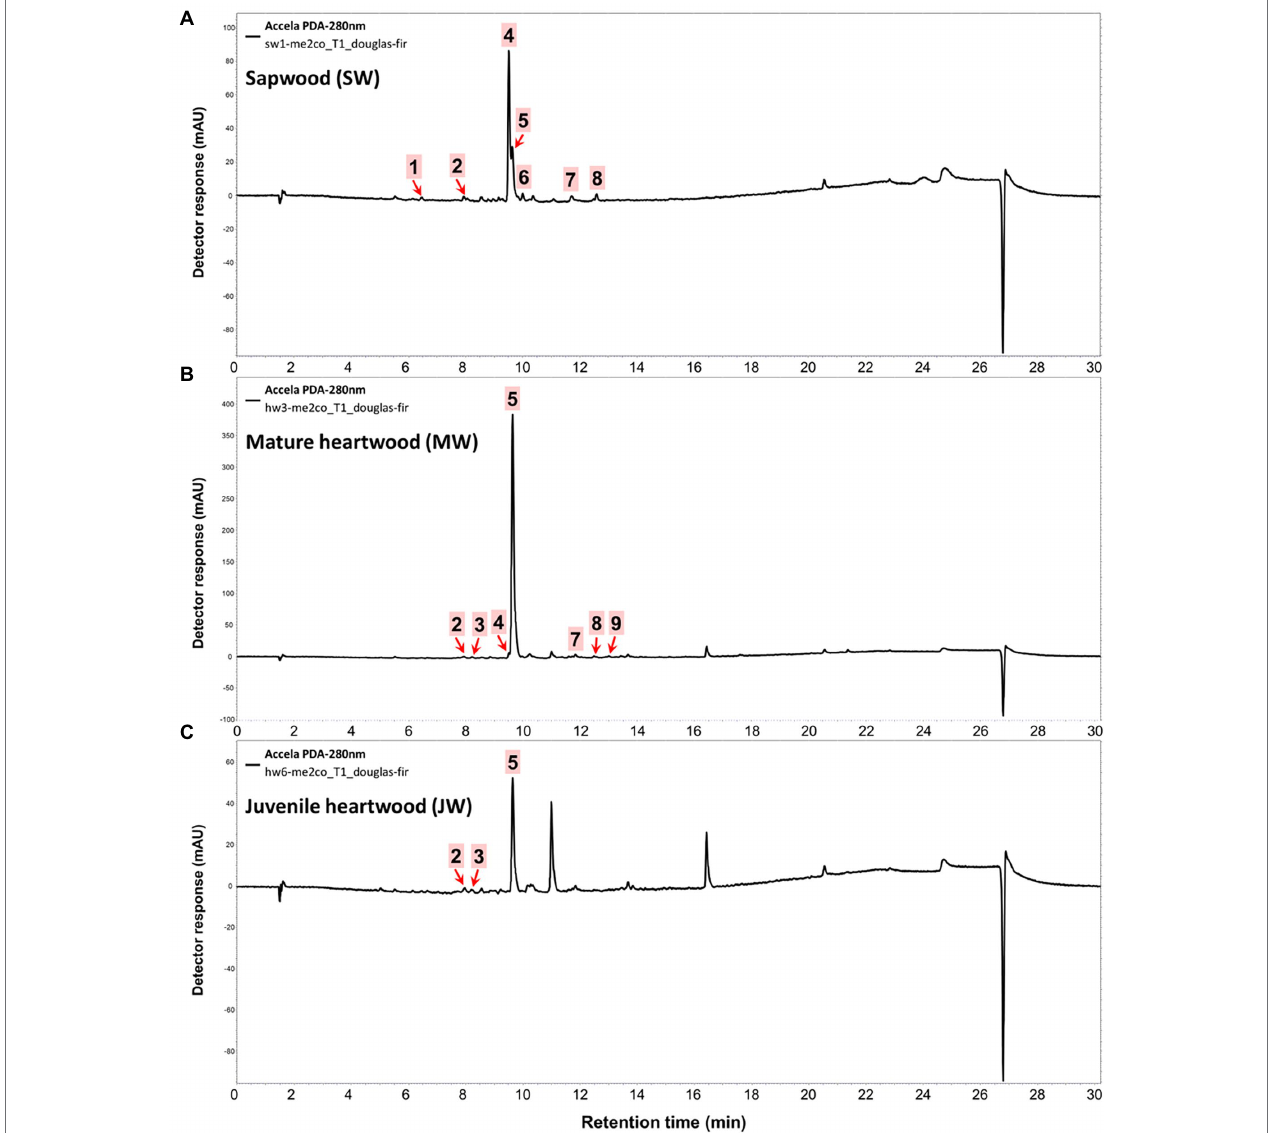
FIGURE 5 | HPLC chromatograms of acetone extracts from (A) sapwood, (B) adult heartwood and (C) juvenile Douglas fir ( Pseudotsuga menziesii ). For peak assignment, see Table 2